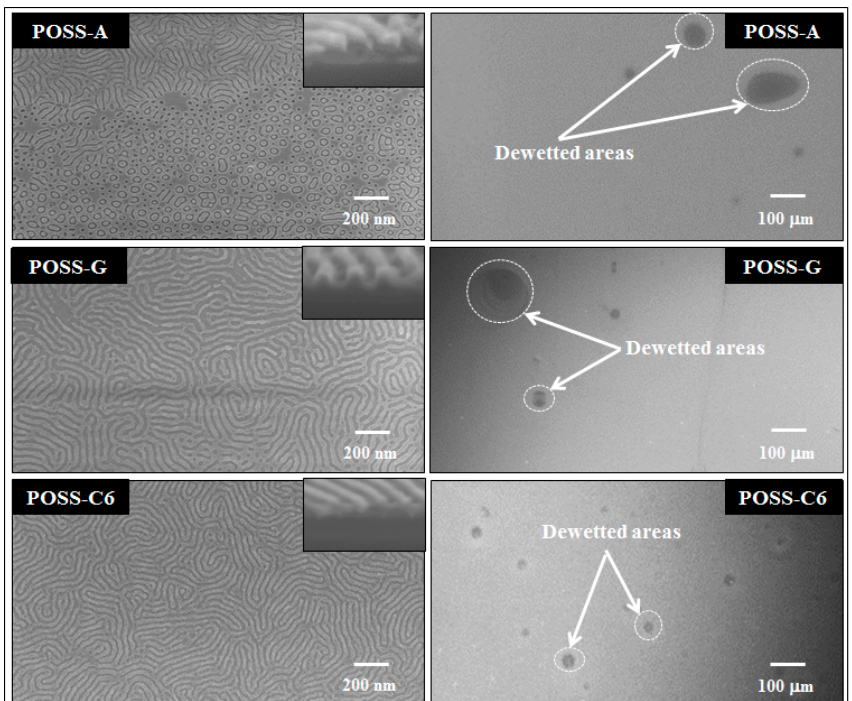
Figure 2. Top-down SEM images of lamellar PS- b -PDMS patterns ( left side ) (inset, cross-section images) and coverages of microphase separated PS- b -PDMS films ( right side ) following ETCH1 at silicon substrates modified with various POSS thin films.